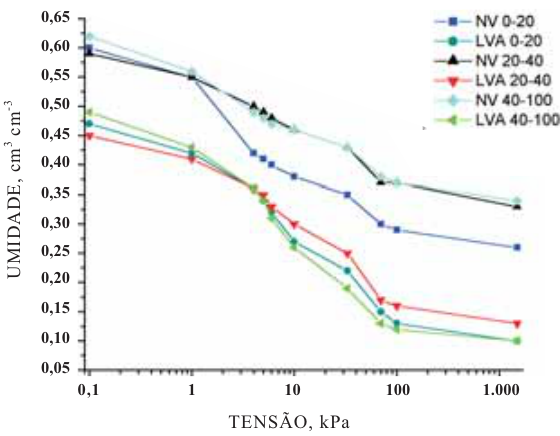
Figura 4. Curva de retenção de água para três profundidades dos solos NV e